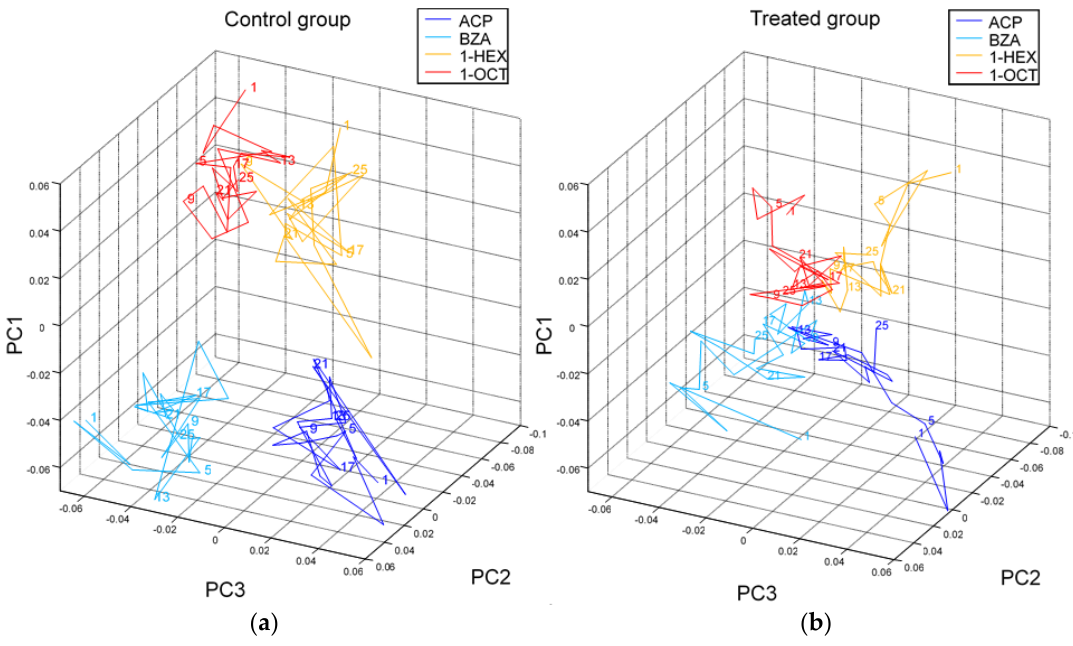
Figure 2. Odour representations in the AL: Glomerular response maps are displayed in principal components (PCs). The trajectories represent 25 odorant stimulus repetitions (marked by numbers along the trajectories) in control ( a ) and treated ( b ) bees. Imidacloprid was administered on average